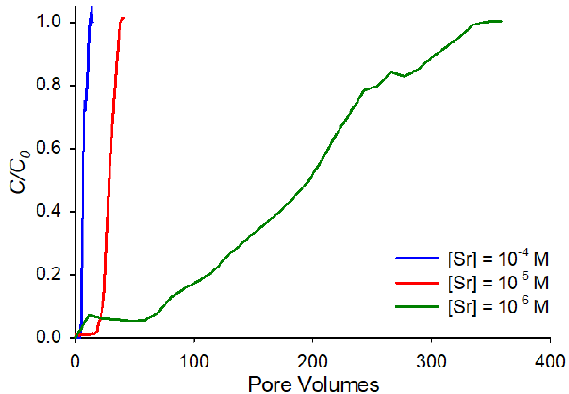
Figure 3. Comparison between breakthrough curves at pH 9, ionic strength 0.001 M NaNO 3 for Sr at concentrations of 10 − 4 M, 10 − 5 M and 10 − 6 M.